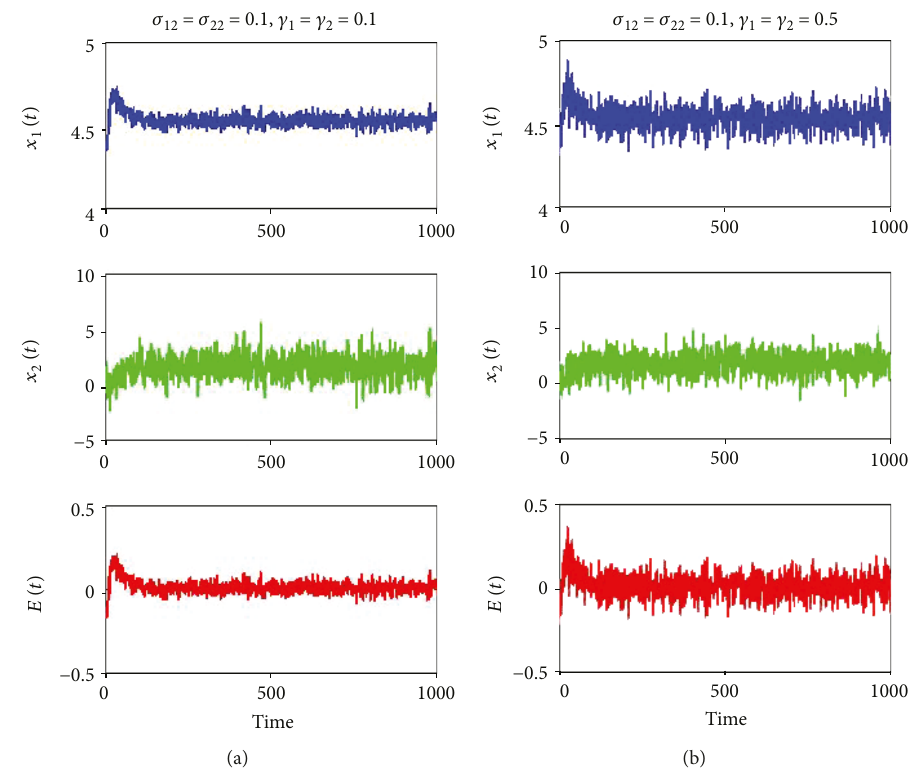
= 2 , b = 0 4 , a = 0 5 , k = 6 , q = 0 1 , m 1 1 1